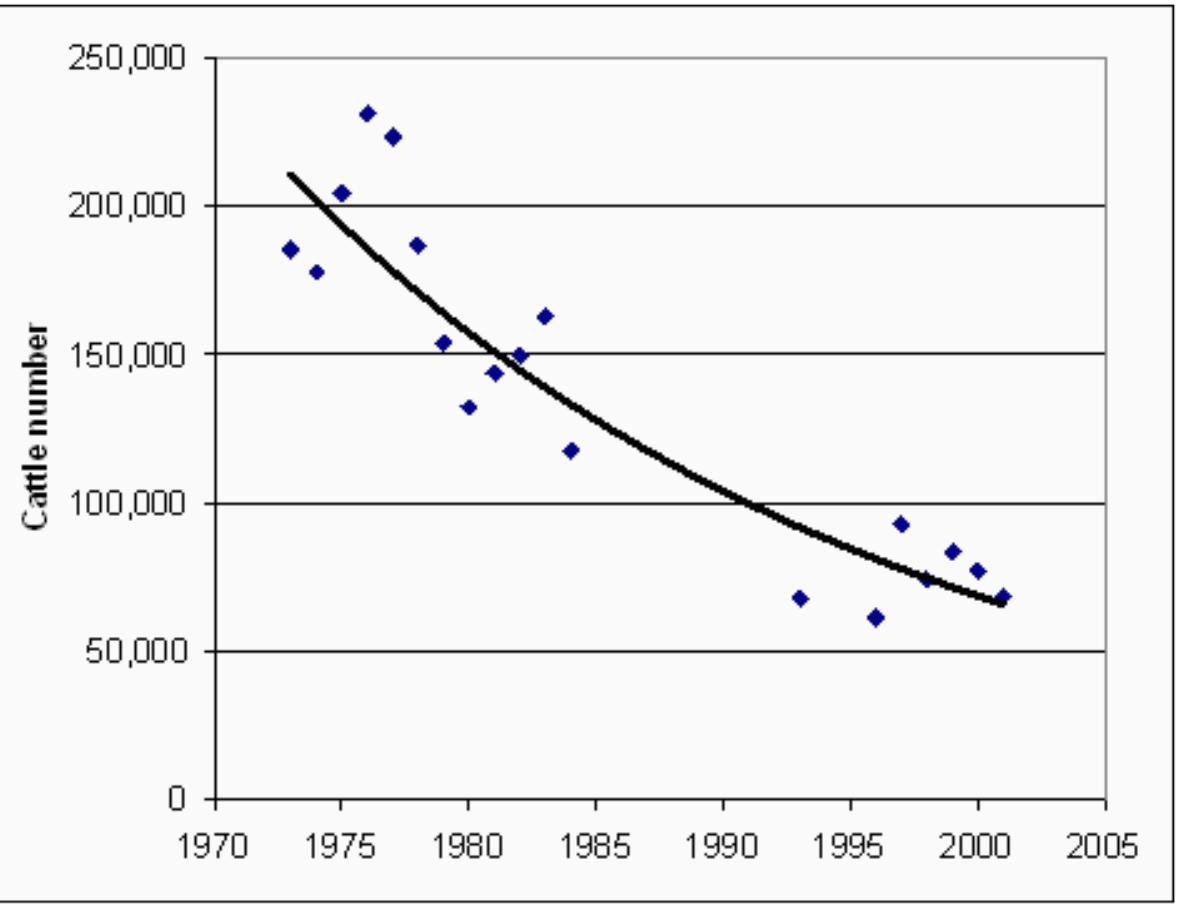
Fig. 1 . The decline in beef cattle held on commercial ranches in the eastern sector of the South East Lowveld, Zimbabwe, from 1973 to 2001, based on data extracted from the annual livestock census reports of the Central Statistical Office and the Department of Veterinary